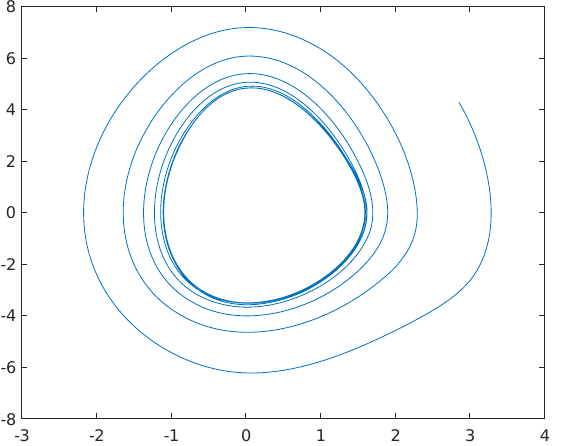
Figure 1. Phase portrait of (30) with (( u ( 0 ) , v ( 0 )) T = ( 2.856,4.2840 ) T